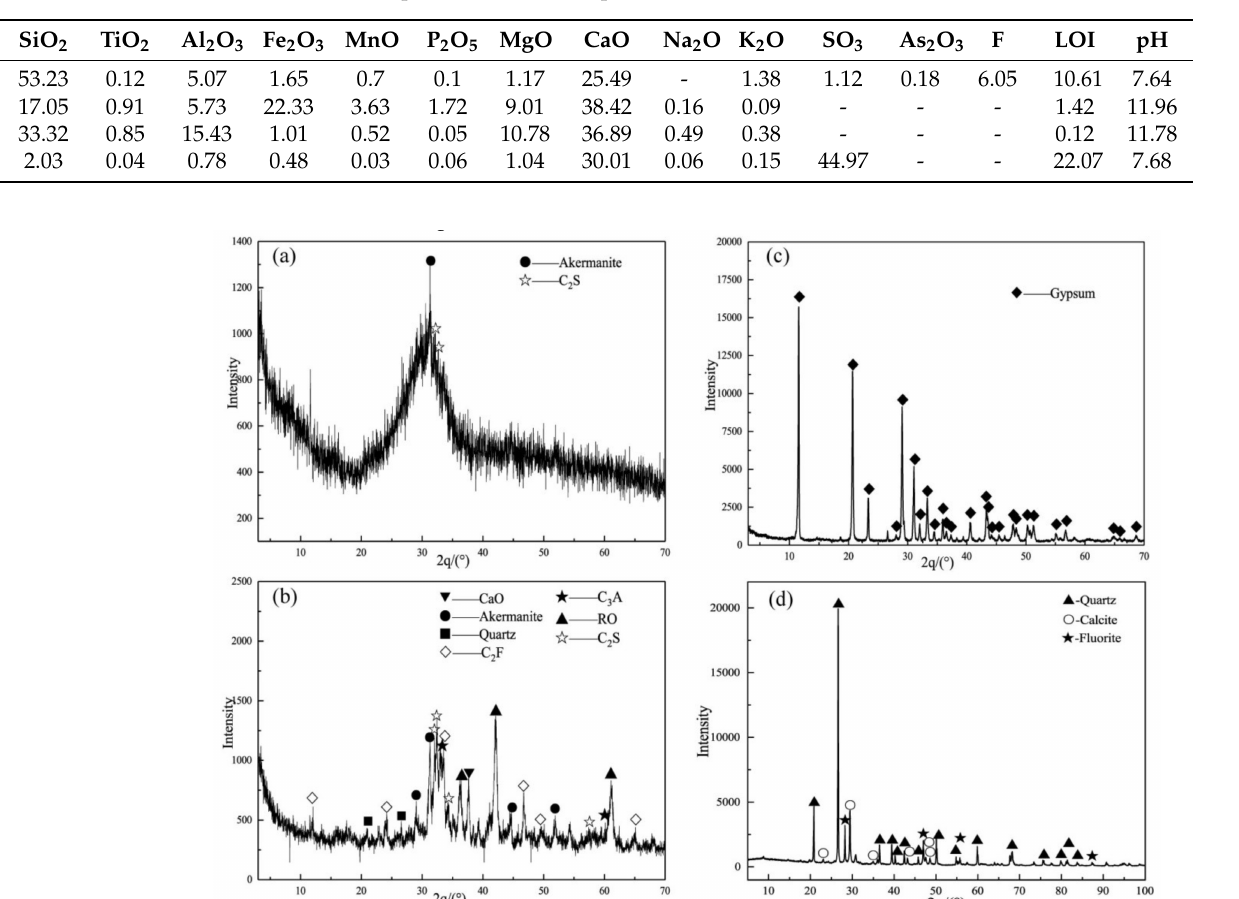
Table 1. Chemical components (wt.%) and pH value of the raw materials.